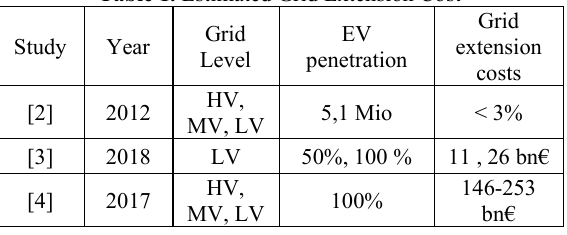
Table 1. Estimated Grid Extension